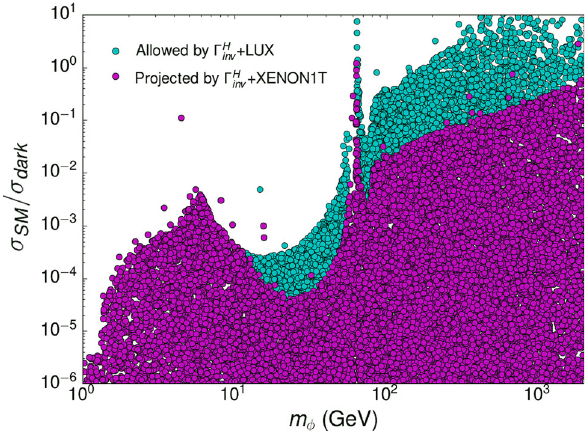
Fig. 6 Ratio between the cross section with standard model particles in the final state and sterile neutrinos in the final state at v = 10 − 3 c , as relevant for indirect detection searches. Currently, on the resonance m φ (cid:11) m h / 2andfor m φ > 150GeVbothcrosssectionsarecomparable. However, XENON1T could set the annihilation cross section to right- handed neutrinos to be dominant in the entire parameter space but for the